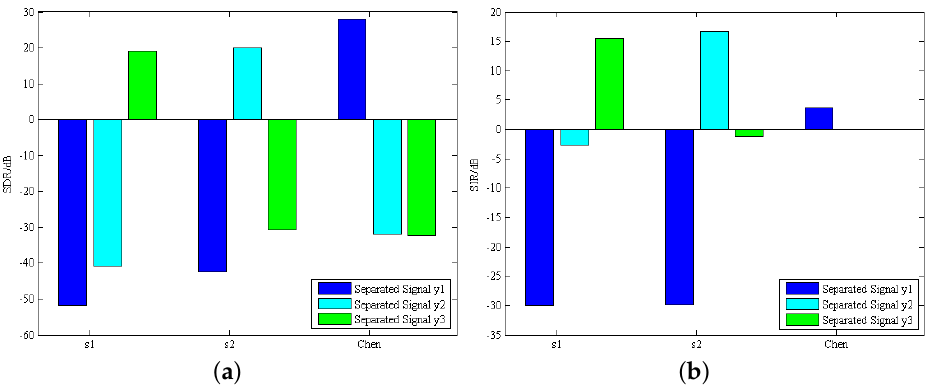
Figure 7. The evaluation of algorithm separation performance with different metrics. ( a ) SDR value; ( b ) SIR